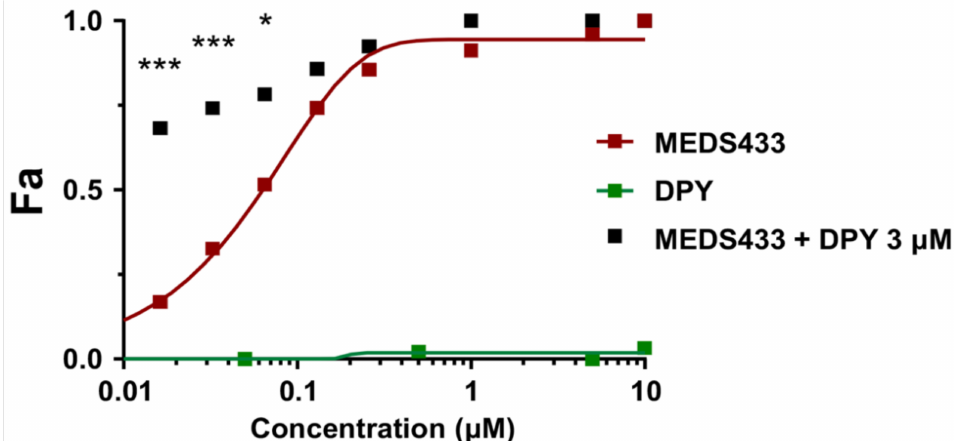
Figure 6. Effects of the combination of MEDS433 and dipyridamole on IAV replication. VRAs were performed in A549 cells treated with MEDS433 alone or in combination with different concentrations of DPY. At 48 h p.i., the cell supernatants were harvested and titrated by the plaque assay in MDCK cells. The effect of the combination was then analyzed by the CompuSyn software [36] and displayed as a fractional effect analysis (Fa) plot in relation to the compound concentrations. The anti-IAV activity of MEDS433 and DPY when used as single agents is depicted by red and green Fa curves, respectively. The effect of the MEDS433-DPY combination is shown with black squares. Results are representative of three independent experiments performed in triplicate and analyzed by a two-way ANOVA, followed by Dunnett’s multiple comparison test. Statistical analysis was performed by comparing MEDS433-treated samples with the MEDS433 + DPY-treated samples for each condition. * ( p < 0.01); *** ( p <